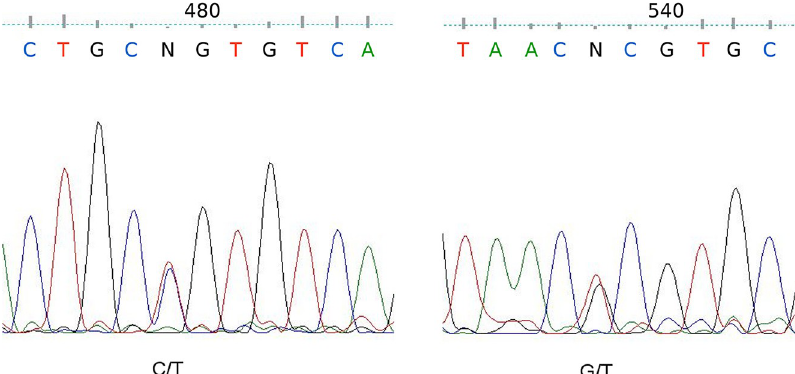
Fig 4. Phylogenetic tree of An . sundaicus s.l. based on the rDNA ITS2 fragment (Panel A) and concatameric mtDNA COI (Panel B). The percentage of replicate trees in which the associated taxa clustered together in the bootstrap test is shown next to the branches. The optimal tree with the sum of branch length = 0.01841176 is depicted. The tree is drawn to scale, with branch lengths in the same units as those of the evolutionary distances used to infer species relationships. Some specimens from North Sumatra (Barbaran and Sebajior) and Bangka-Belitung cluster with An . epiroticus from Malaysia, Vietnam, and Thailand. Site codes: SUT = North Sumatra; SUM = Sumba, East Nusa Tenggara; BB = Bangka Belitung Archipelago; LA = Lampung; JAW = West Java; NTB = West Nusa Tenggara; and BK =